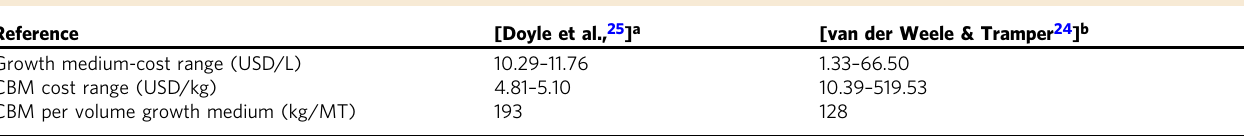
Fig. 2 Geographical distribution of plant-based (green circles) and cell-based (orange circles) meat companies. Companies were included as listed in the Good Food Institute alternative protein company database (August 2020). Table 1 Results from preliminary economic analyses of CBM production 24,25